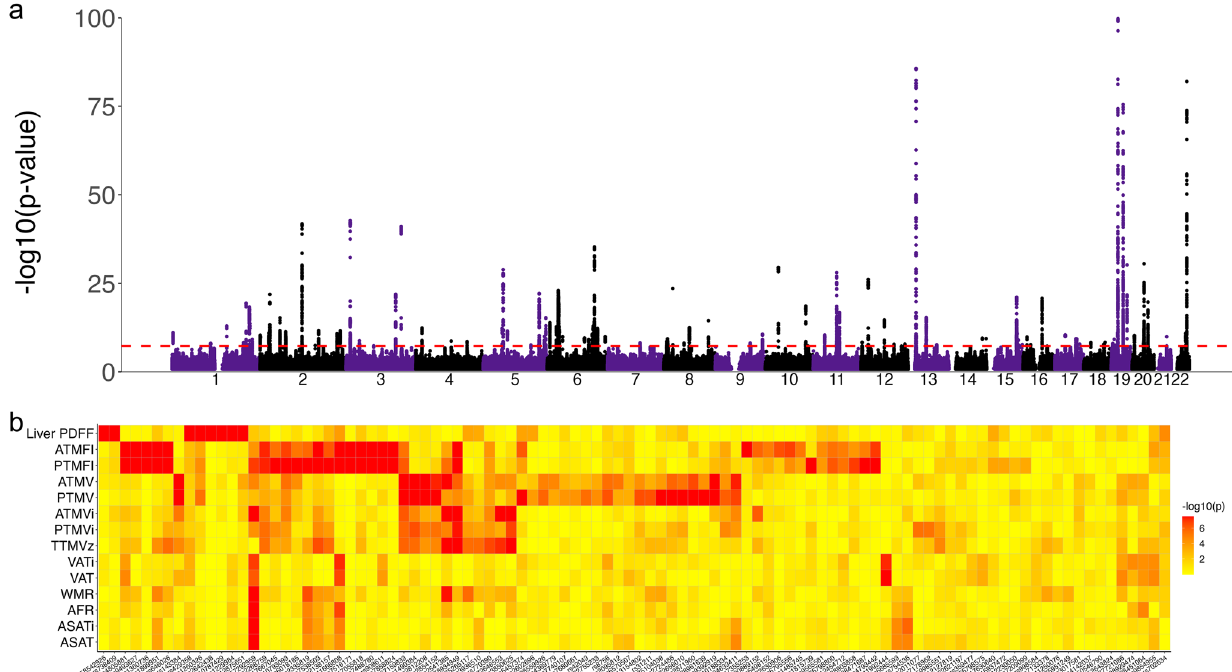
Fig. 2 Multivariate locus discovery. a Manhattan plot of the multivariate GWAS on all MRI-derived body composition measures, with the observed − log10( p ) of each SNP shown on the y -axis. The x -axis shows the relative genomic location, grouped by chromosome, and the red dashed line indicates the whole-genome signi fi cance threshold of 5 × 10 − 8 . The y -axis is clipped at − log10( p ) = 75. b Heatmap showing − log10( p ) of the association between the lead variants of MOSTest-identi fi ed independent loci ( x -axis) and each of the individual MRI measures ( y -axis). The values are capped at 7.5 ( p = 5 × 10 − 8 ).